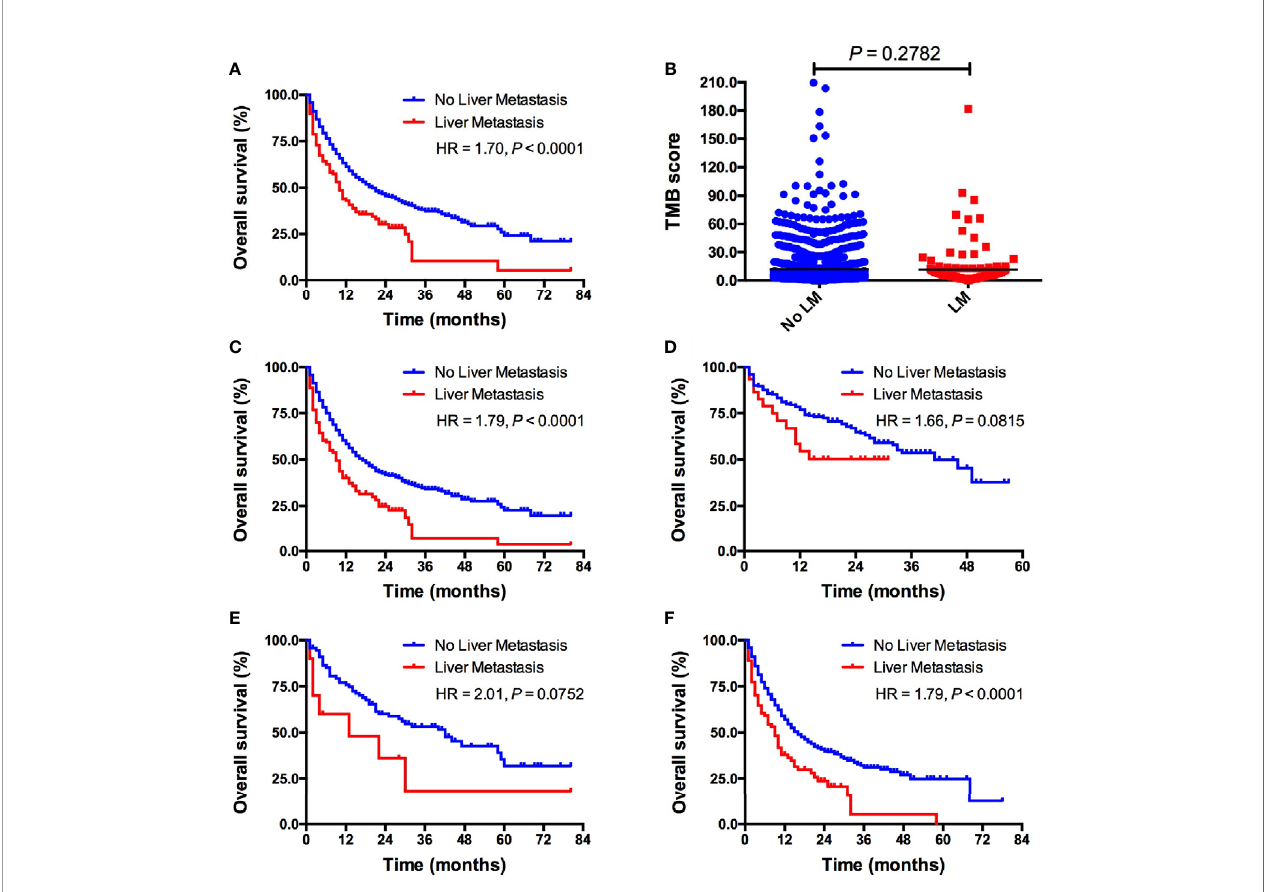
FIGURE 1 | Pan-cancer analysis of the predictive value of LM for ICIs treatment outcomes. (A) OS comparison between patients with vs. without LM in whole cohort; (B) TMB level comparison between patients with vs. without LM in whole cohort; (C) OS comparison between patients with vs. without LM in ICIs monotherapy group; (D) OS comparison between patients with vs. without LM in ICIs based combination therapy group; (E) OS comparison between patients with vs. without LM in PD-1/PD-L1 monotherapy group; (F) OS comparison between patients with vs. without LM inCTLA-4 monotherapy group. LM, liver metastasis; TMB, tumor mutational burden; ICI, immune checkpoint inhibitor.